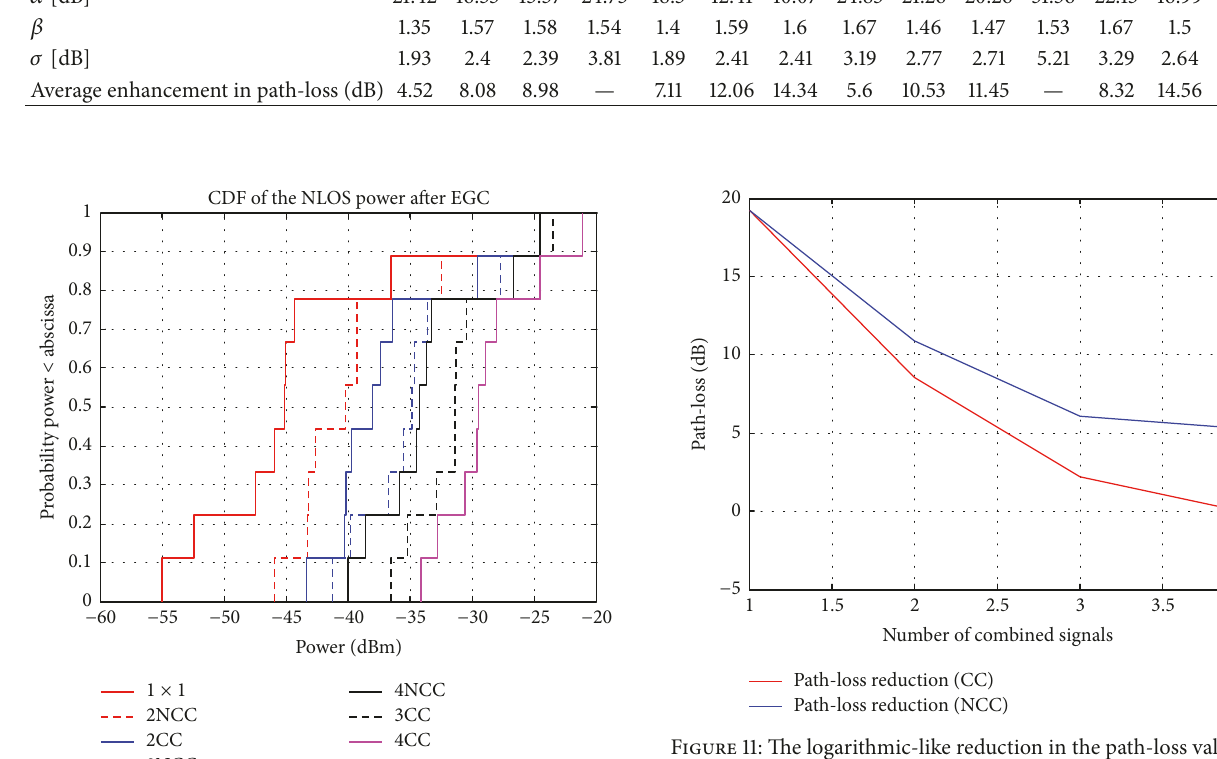
Figure 11: The logarithmic-like reduction in the path-loss values as the number of diversity antennas goes from one up to four at 8 m separation distance for the LOS